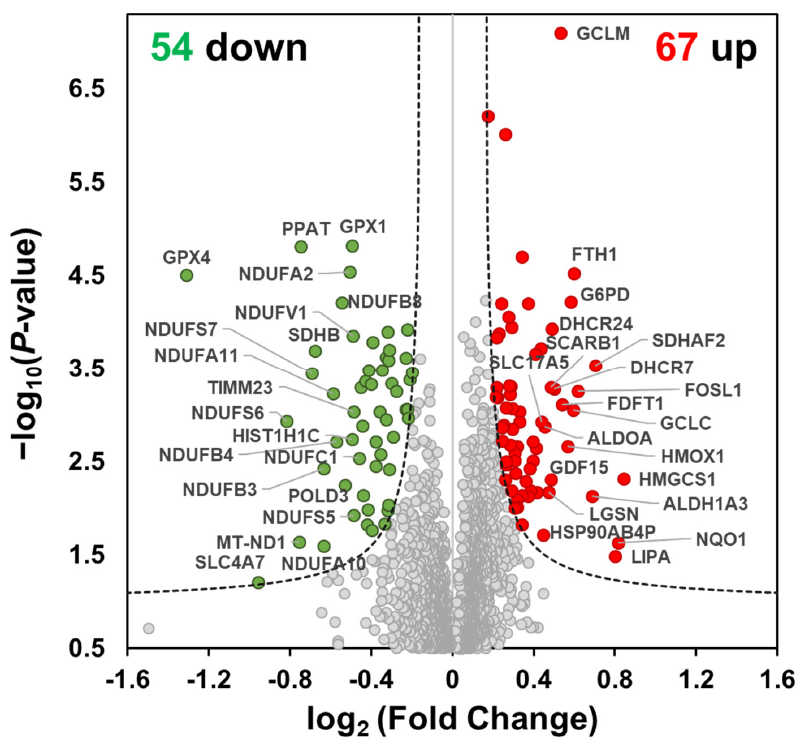
Figure 2. Differentially expressed proteins from the MO-treated HCT116 cells. Volcano plot of MO-treated versus Ctrl-treated proteome in HCT116 cells. X -axis represents the protein fold change in log 2, and y -axis indicates the p -value ( − log 10 ) resulting from a two-sample t -test. Upregulated, downregulated, and unchanged proteins were colored red, green, and grey, respectively. The black dashed lines indicate the significance threshold (FDR = 0.05, s0 = 0.07592023 from SAM).